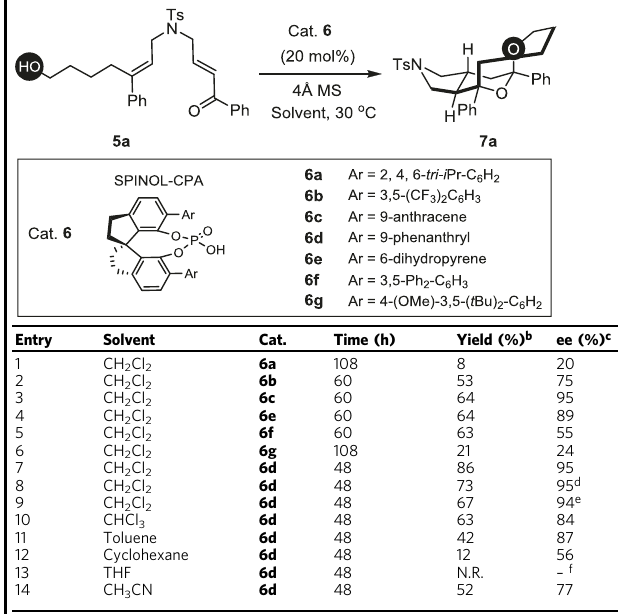
Table 1 Optimization of the reaction conditions a